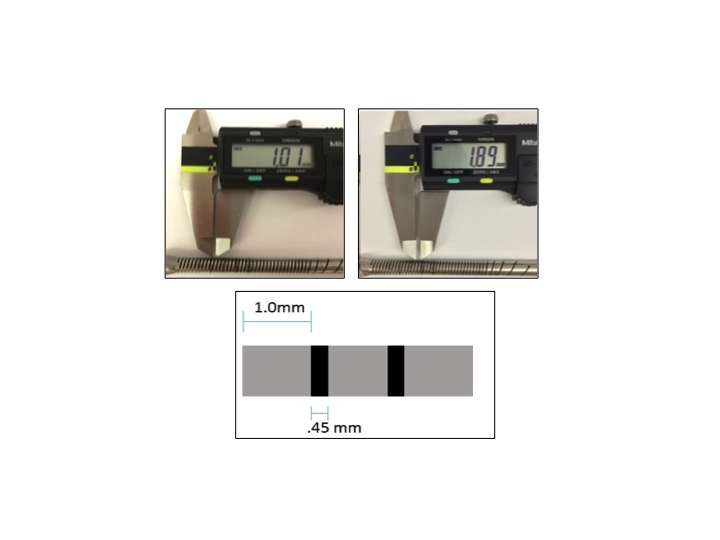
 Digital caliper measurement of flexible reamer links and gaps for femoral tunnel length measurements.